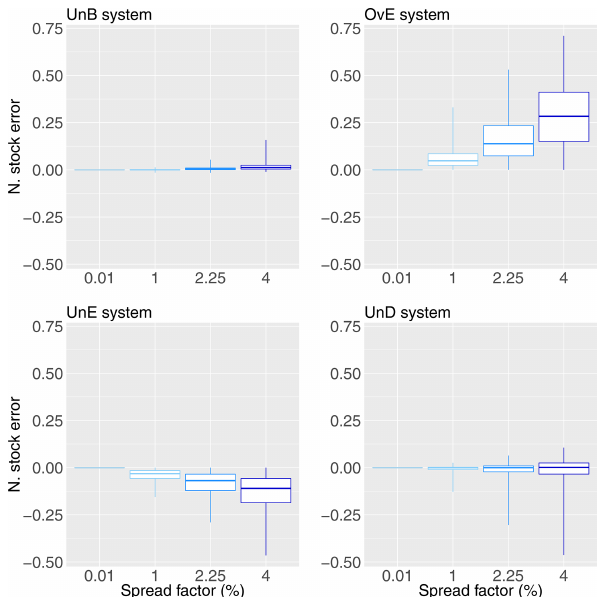
Figure 13. Normalized differences in stock between the operation with the reference system (i.e., the “perfect system”, where fore- casts are equal to observations) and the operation with the synthetic forecasting systems: unbiased system (UnB), underdispersed sys- tem (UnD), underestimating system (UnE) and overestimating sys- tem (OvE). Synthetic systems are based on ensembles generated with four different spread factors (0.01%, 1%, 2.25% and 4%). Boxplots represent the maximum value, percentiles 75, 50 and 25, and minimum value over the 10 studied catchments.